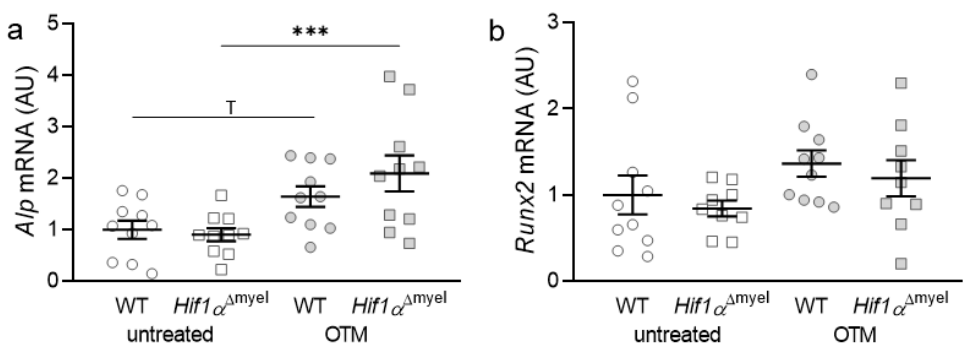
Figure 1. Gene expression of Alp ( a ) and Runx2 ( b ) at the orthodontically treated (OTM) and the untreated control jaw side in wildtype mice (WT) and mice without HIF1 α in myeloid cells ( Hif1 α ∆ myel ). Statistics: ANOVA with uncorrected Fisher’s LSD post-hoc tests ( Alp ) or Welch-corrected ANOVA with unpaired t tests ( Runx2 ). n ≥ 9; *** p ≤ 0.001, T p ≤ 0.1.